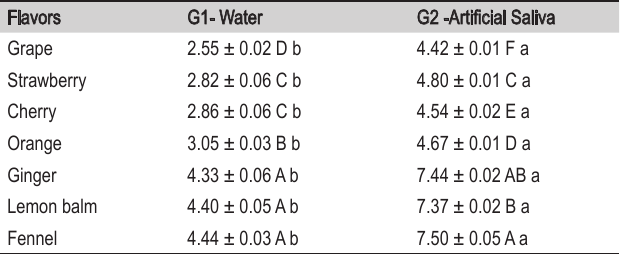
Table 1 - Mean ± standard deviation values of pH of the different flavors of candies, after dilution in water (G1) or artificial saliva (G2).